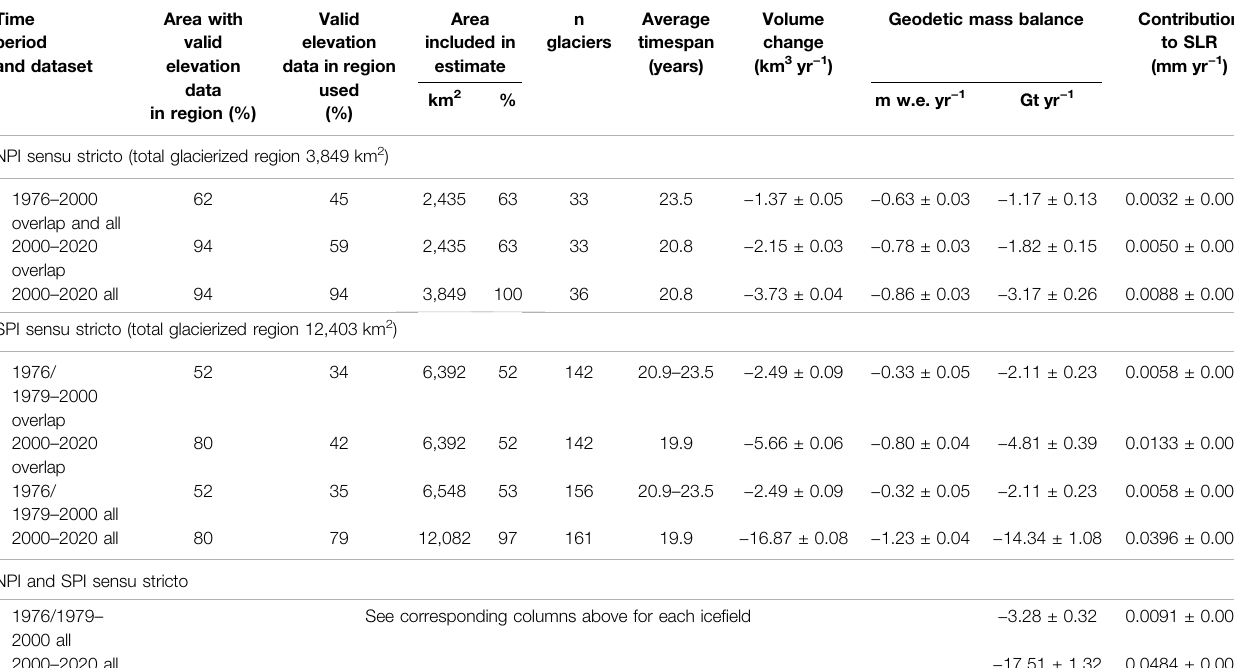
TABLE3| Area-weightedgeodeticmassbalanceoftheice fi elds.Totalglacierizedareaiscalculatedfromyear2000glacieroutlines. “ Areawithvalidelevationdatainregion ” corresponds to percent of the total glacierized region which has valid elevation data (includes all glaciers, not only those that have more than 50% valid data). “ Valid elevation data used ” corresponds to the valid data (of the entire region) that is utilized in the aggregation (i.e., the data that was within glaciers with at least 50% data coverage). “ Areaincludedintheestimate ” isthetotalarea(dataplusinterpolatedarea)includedintheaggregationforthegeodeticmassbalanceestimatewithrespecttothe total glacierized area, including only glaciers that had at least 50% valid elevation data. For example, 63% in the fi rst column represents the unhatched glaciers on the ice fi eld (which all include some interpolation) in Figure 3A . “ Number of glaciers included in the estimate ” are those that had at least 50% valid elevation data before interpolation.